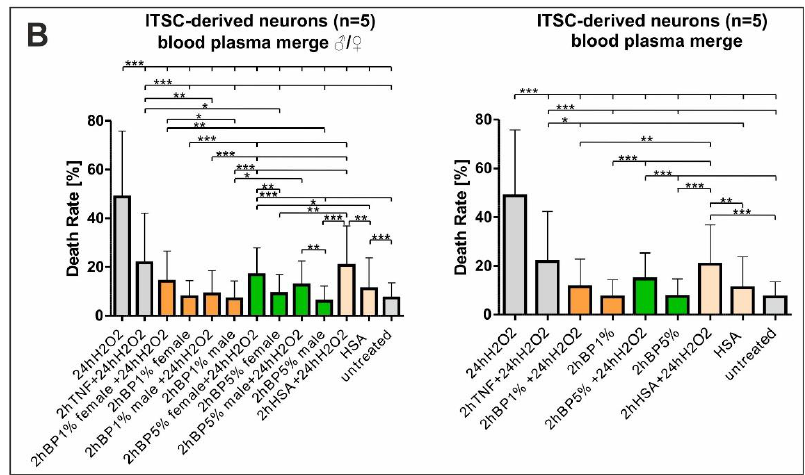
Figure 4. Human plasma mediates neuroprotection against oxidative stress ( A ) Nuclear counter- staining with 4′,6-diamidino-2-phenylindole (DAPI) (green color) showed the morphological changes in nuclear shape, indicated by strongly condensed or fragmented chromatin, after the different treatments revealing an increase in cell death. Fragmented or condensed nuclei are indicated by a red arrow. ( B ) For analysis of human neuronal survival, the amount of nonviable inferior turbinate stem cell (ITSC)-derived neurons recognized by nuclear condensation and/or fragmented chromatin was counted by randomized analysis of 5 pictures per treatment, and donor and death rate was calculated. Quantification of neuronal death for the data collected from three male plasma and two female plasma donors depicted no sex specificity, but an overall neuroprotective effect against oxidative stress treatment. ITSCs: inferior turbinate stem cells; TNF: tumor necrosis factor α; BP: blood plasma; HSA: human serum albumin, H 2 O 2 : hydrogen peroxide. * p ≤ 0.05, ** p ≤ 0.01, *** p ≤ 0.001 was considered significant.